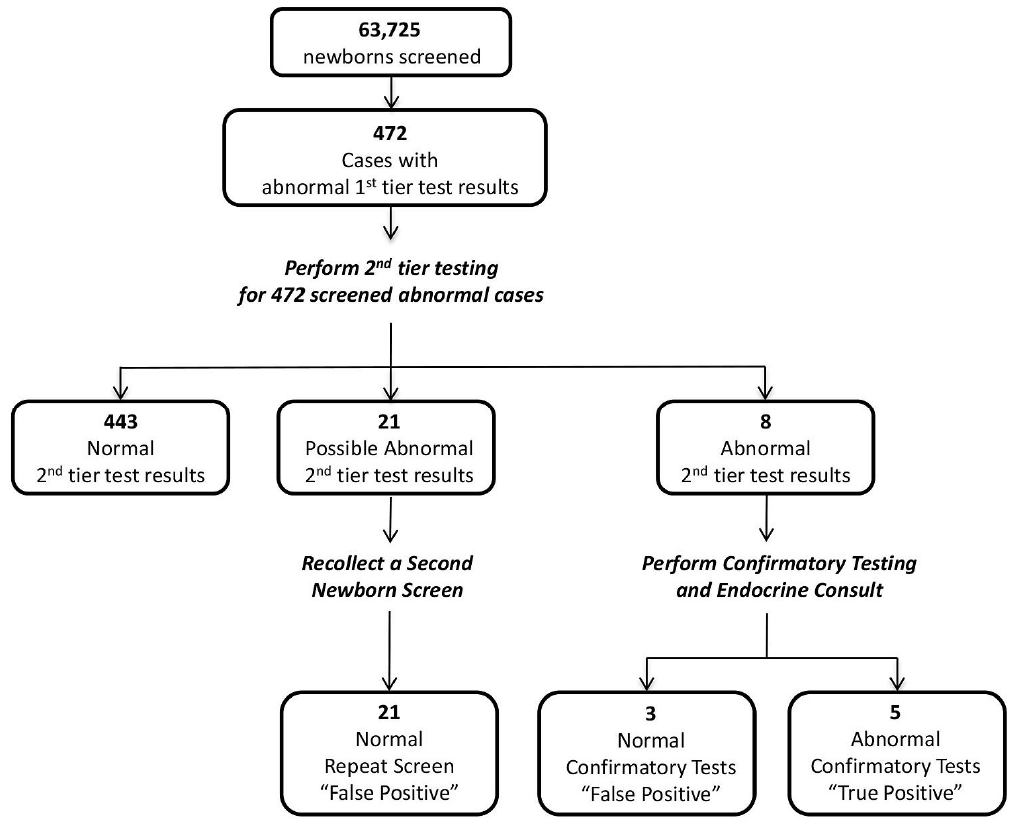
Figure 3. Summary of prospective study. Figure 3 summarizes data from the prospective